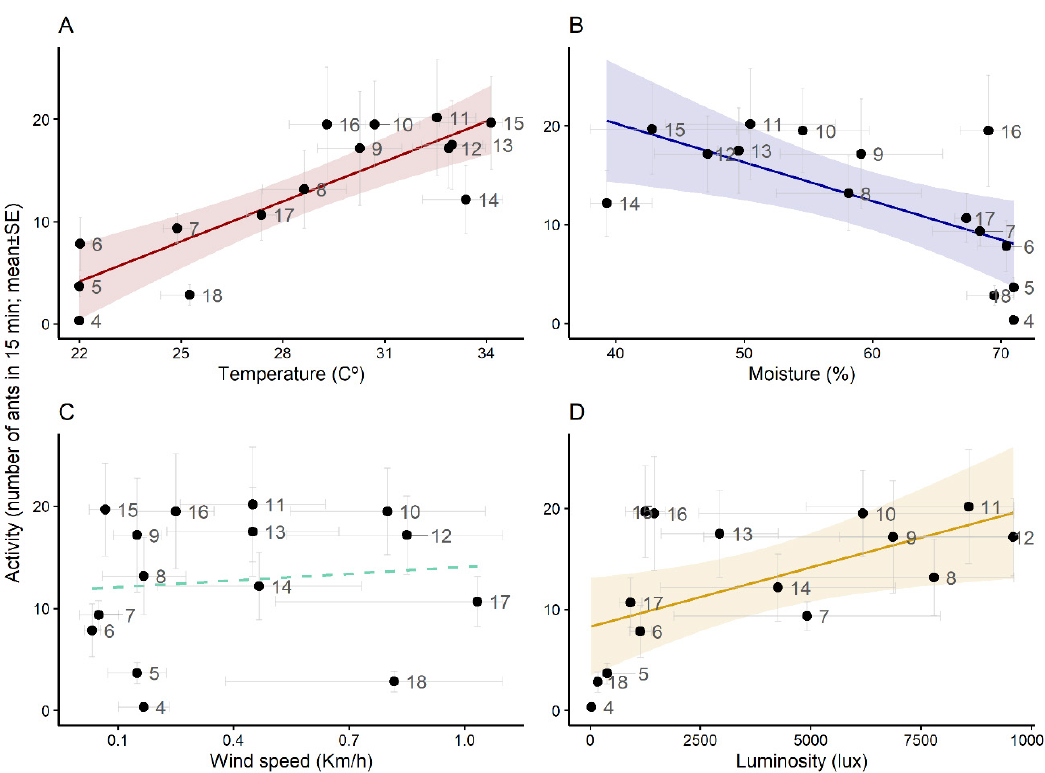
Fig 3 . Relationship between abiotic factors and the number of foragers of Cephalotes borgmeieri in activity every 15 minutes. (A) Temperature, (B) air humidity, (C) wind speed and (D) luminosity recorded in six colonies on the campus of University City, Dourados, Mato Grosso do Sul, Brazil. (Cloud along the continuous line indicates the regression confidence interval; dotted line indicates non-significant variable; black dots indicate the mean foraging activity and environmental variable in the six colonies at the respective time; confidence intervals indicate the standard error of the mean for foraging activity and environmental